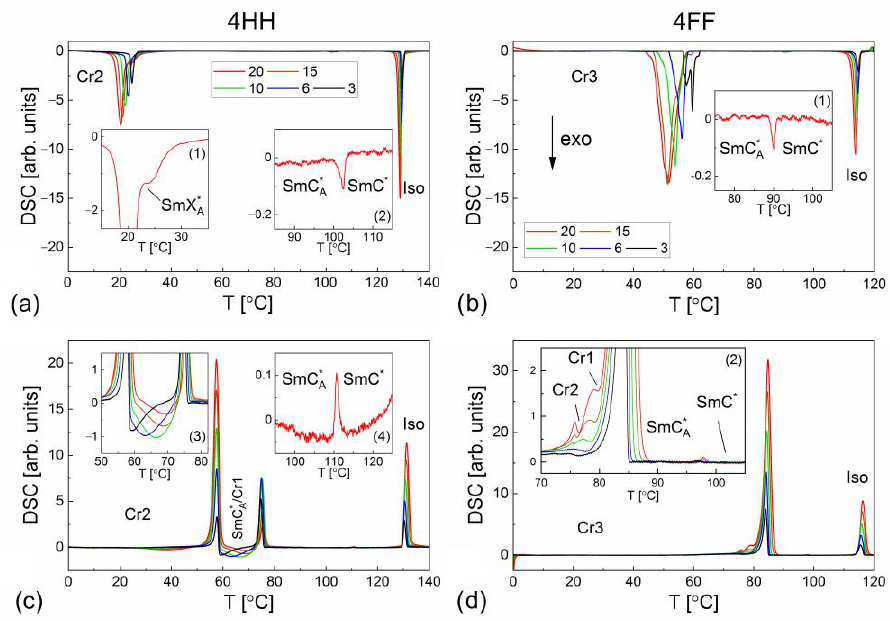
Figure 3. DSC curves registered during cooling ( a , b ) and heating ( c , d ) with 3 – 20 °C/min rates for 4HH ( a , c ) and 4FF ( b , d ). The legends in ( a , b ) apply also to panels ( c , d ).